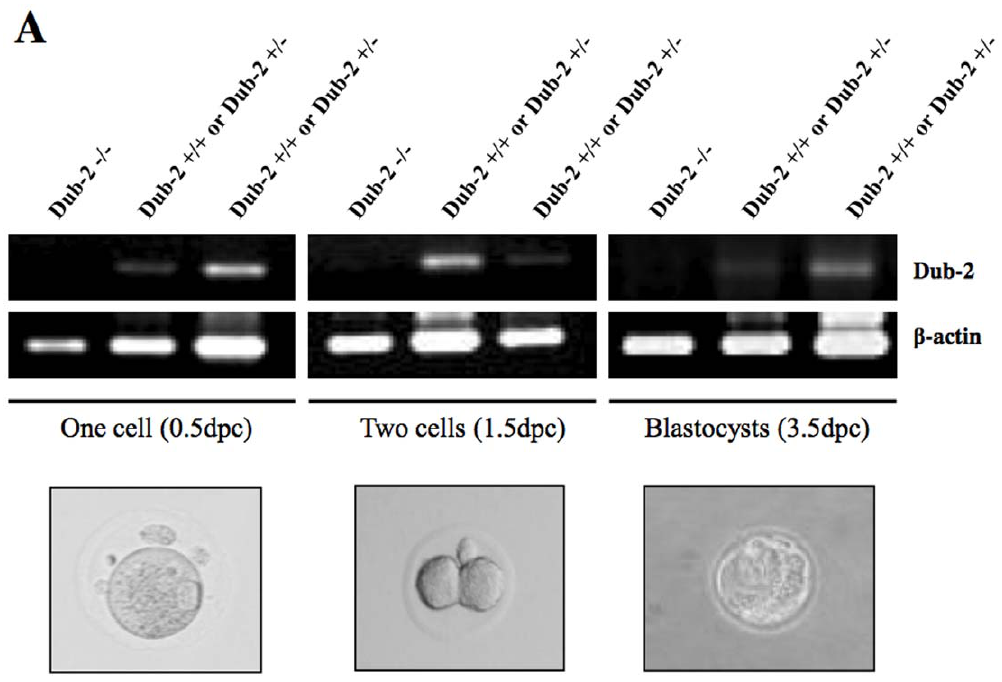
Figure 4. Dub-2 2 / 2 embryos fail to hatch invitro . A) Genotyping by genomic PCR. 330 bp, amplified by using Dub F and Dub R primers, represents either Dub-2 + / + or Dub-2 + / 2 , whereas no band represents Dub-2 2 / 2 . Dub-2 2 / 2 embryos were found between 0.5dpc and 3.5dpc. B) Out-growth inner cell mass was harvested and then genotype was confirmed by 2-primers PCR (Dub F and Dub R) as described in Materials and Methods. Developmental defects in Dub-2 2 / 2 embryos at the 5.5dpc stage were shown in vitro . ICM grew normally and was surrounded by trophoblast giant cells in Dub-2 + / + and Dub-2 + / 2 embryos. In contrast, Dub-2 2 / 2 5.5dpc embryos did not hatch to the culture dish. C) The number of hatching status of 3.5dpc embryos after 96 hrs of culture in vitro . Dub-2 deficiency leads to failure to hatch in vitro . D) Analysis of TUNEL assay was performed for cell death. Arrows pointing spots indicate cells undergoing apoptosis. E) E3.5 blastocysts were isolated, and after 24 hrs in culture, their ZP was mechanically removed. The ZP-free embryos were cultured on feeder layer in ES cell medium. F) Dub-2 + / + and Dub-2 + / 2 mES cell lines.